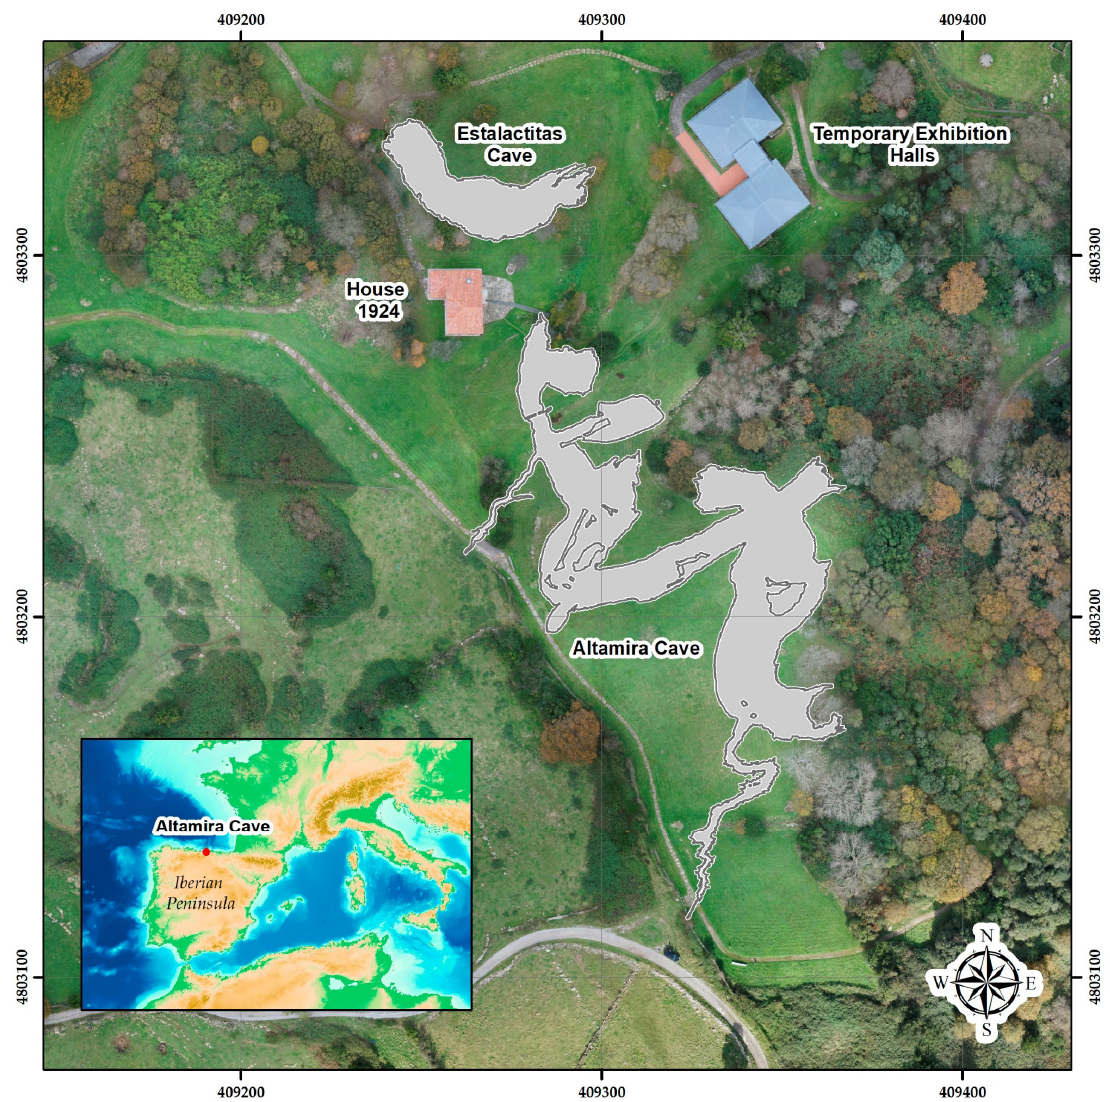
Figure 1. Location map and the surroundings of Altamira Cave. The cave is located in Santillana del Mar, Cantabria, Spain.